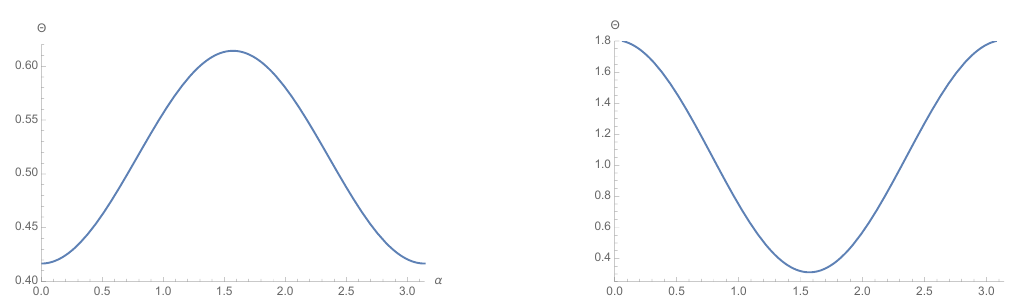
Figure 1. The coe(cid:14)cient (cid:2)( (cid:11) ) in (2.10) for spacetime-(cid:12)lling probe D2-branes on the N = 0 SU(3)- invariant vacua with cosmological constants V = (cid:0) 23 : 4136 g 2 c (cid:0) 1 3 (left) and V = (cid:0) 23 : 4567 g 2 c (cid:0) 1 3